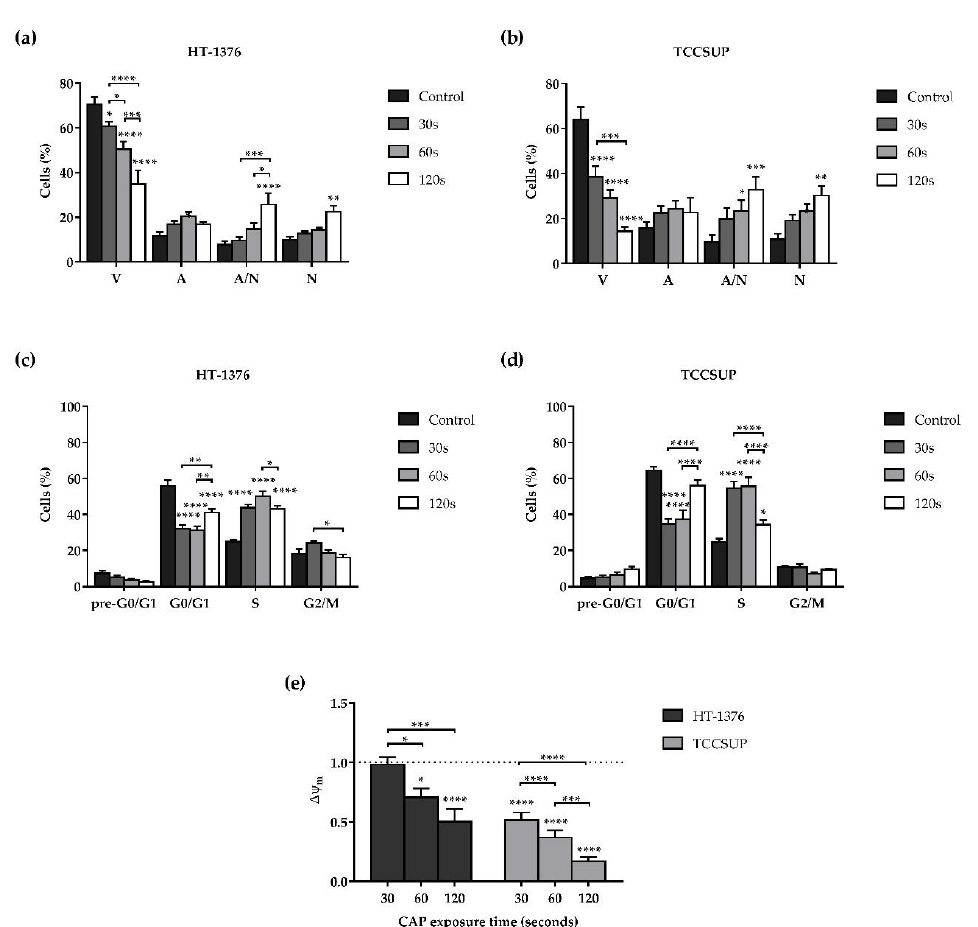
Figure 2. CAP treatment decreases cell viability, induces cell cycle alterations, and depolarization of the ∆ ψ m of HT1376 ( a , c , e ) and TCCSUP ( b , d , e ) cell lines in a time of exposure-dependent manner. The viability and cell death profile (n ≥ 4 independent experiments in triplicate), cell cycle progression (n ≥ 3 independent experiments in triplicate), and the ∆ ψ m (n = 4 independent experiments in triplicate) were evaluated by flow cytometry 24 h after CAP treatment. ( a , b ) Results of viability and cell death profile are expressed as the mean ± SEM of the percentage of viable cells (V), cells in initial apoptosis (A), cells in late apoptosis/necrosis (A/N), and cells in necrosis (N). ( c , d ) Results of cell cycle progression are expressed as the mean ± SEM of the percentage of cells identified in each phase: pre-G 0 /G 1 , G 0 /G 1 , S, and G 2 /M. ( e ) Results of Δψ m are expressed as the mean ± SEM of aggregates/monomers (A/M) ratio normalized to control. p value was reported as * p ≤ 0.05, ** p ≤ 0.01, *** p ≤ 0.001, **** p ≤ 0.0001. Representative dot plots, from the HT-1376 cell line, of the viability and cell death profile, cell cycle analysis, and the Δψ m assays are presented in Figures S1‒3 in the supplementary materials.